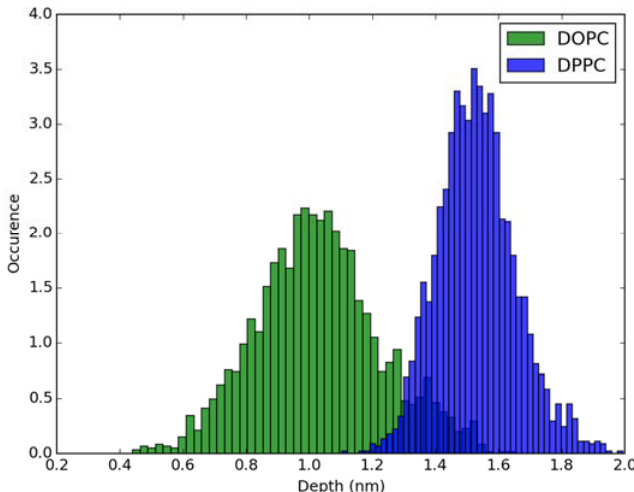
Molecules 2018 , 23 , x FOR PEER REVIEW Figure 6. Histogram of penetration depth of Laurdan fluorophore in the S 1 state into lipid bilayers.